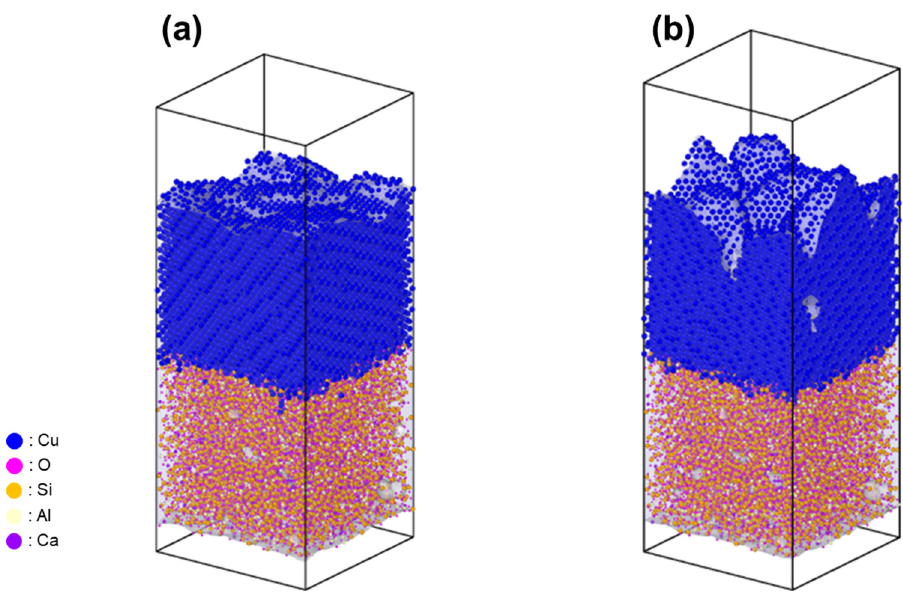
Figure 6. Surface morphology of Cu films grown onto CAS substrate: ( a ) high E Inc and ( b ) low E Inc case. E Inc